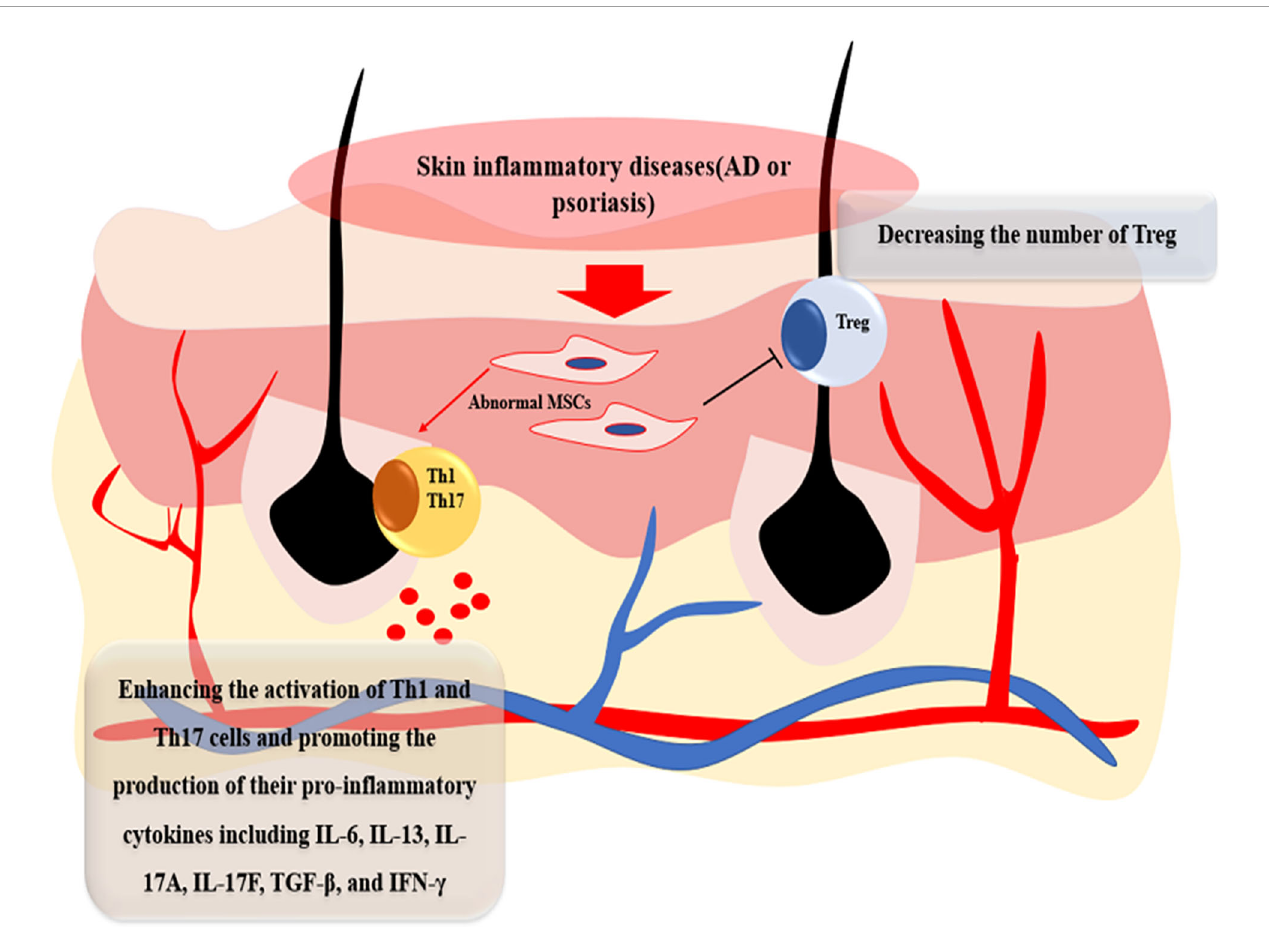
FIGURE 1 The effects of lesional MSCs in AD and psoriasis patients. Compared with MSCs from healthy donor, MSCs in skin lesion of AD and psoriasis patients can enhance the activation of Th1 and Th17 cells and promote the production of their pro-in fl ammatory cytokines including IL-4, IL-6, IL-13, IL-17A, IL-17F, IL-17C, CCL, TNF- a , and IFN- g and suppress the activation of